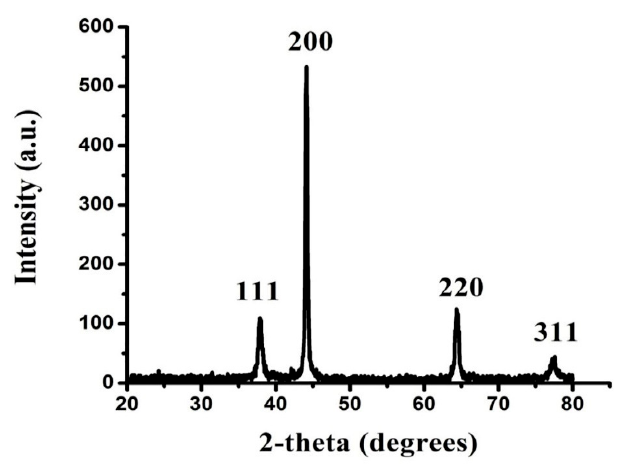
Figure 5. XRD analysis of FAuNPs.